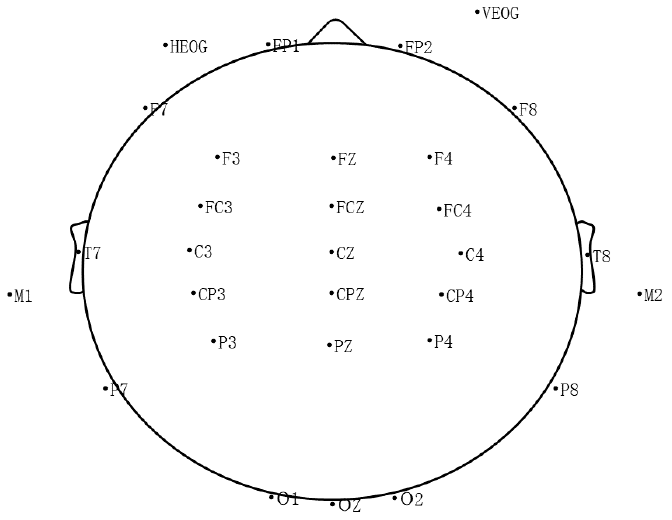
Figure 2. Plot of electrode sites (32 electrodes). The frontal (F3, Fz, F4), frontal–central (FC3, FCz, FC4), central (C3, Cz, C4), central–parietal (CP3, CPz, CP4), and parietal (P3, Pz, P4) were chose for EEG